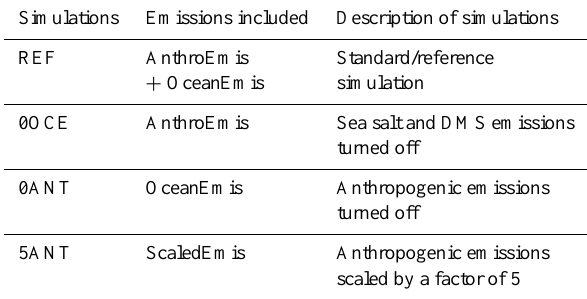
Table 1. Description of four primary model